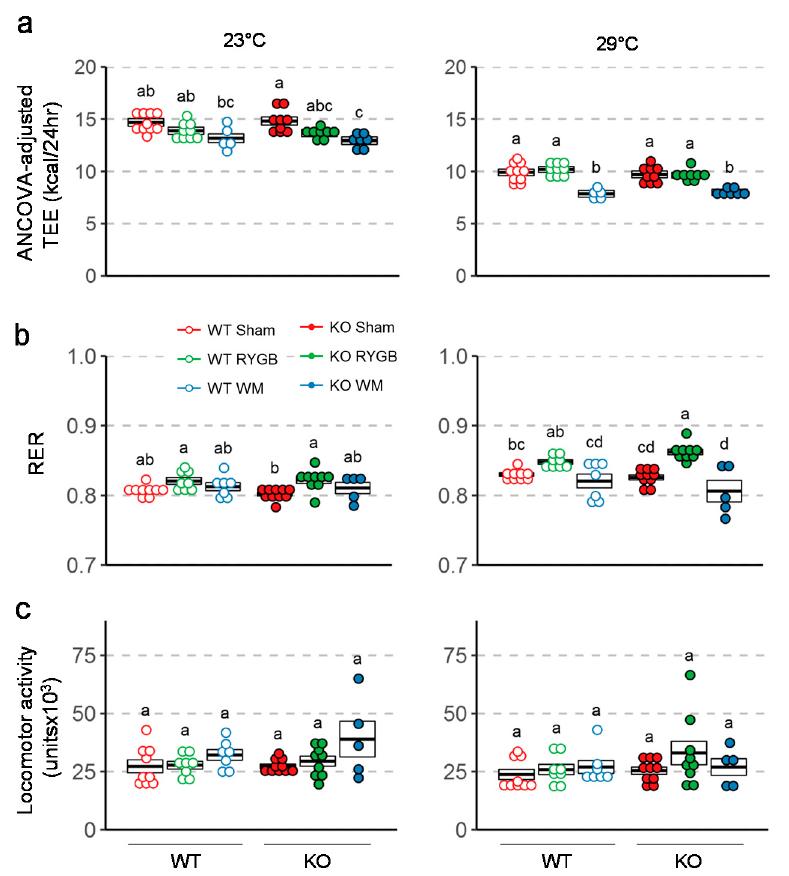
Figure 4. Effect of RYGB, sham surgery, or weight matching to RYGB by caloric restriction (WM) on ANCOVA adjusted energy expenditure using body weight as a covariate ( a ), respiratory exchange ratio ( b ), and locomotor activity ( c ) in Y2RKO and WT mice. Measurements were taken both at room temperature (23 °C) and at thermoneutrality (29 °C) at about 7–8 weeks after surgery. Data are expressed as individual data points over a box showing means ± SEM. Data that do not share the same letters are significantly different from each other ( p < 0.05, pairwise t-tests with Benjamini–Hochberg correction, FDR = 0.05).